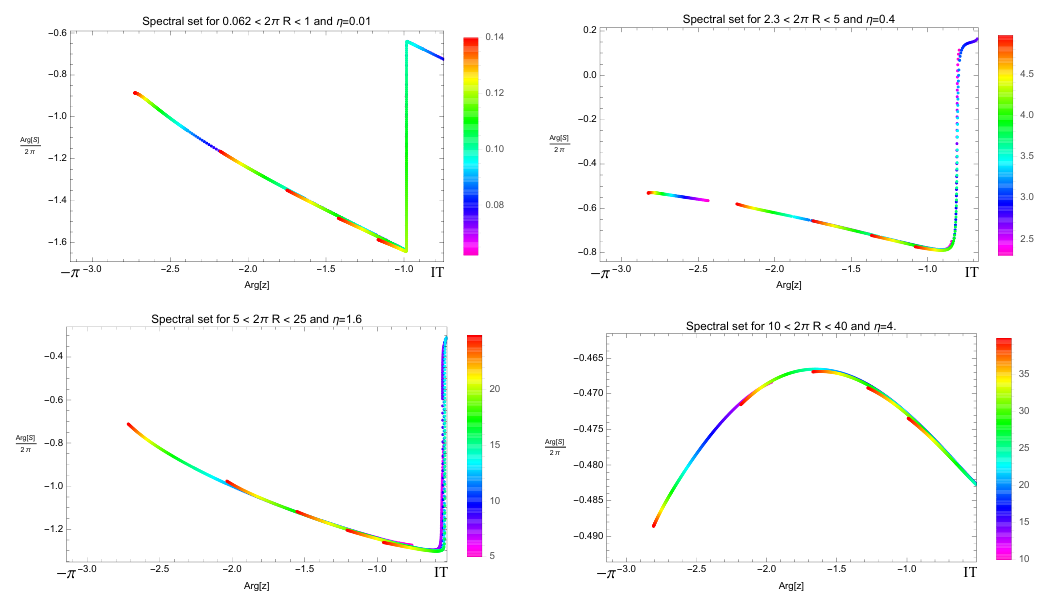
Figure 7. The spectral sets for the scattering phase of a pair of lightest particles as a function of arg( z ) in the elastic regime (from − π to the inelastic threshold), computed at truncation level L = 22 over a suitable range of the cylinder radius R (in units of 1 /m f ), for η = 0 . 01 , 0 . 4 , 1 . 6 , and 4